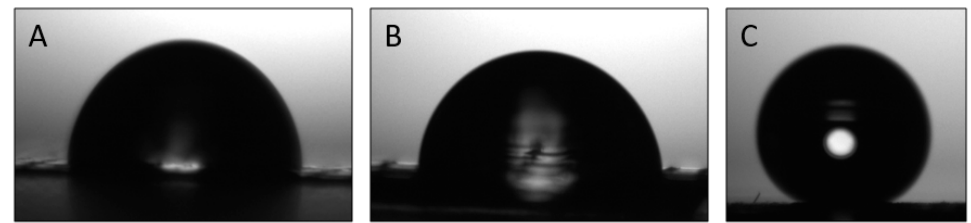
Figure 6. Typical photographs of the water contact angle test: ( A ) PHBV monolayer; ( B ) PA1010/1014 monolayer; and ( C ) PHBV/PA1010/1014/PHBV/SiO 2 multilayer.